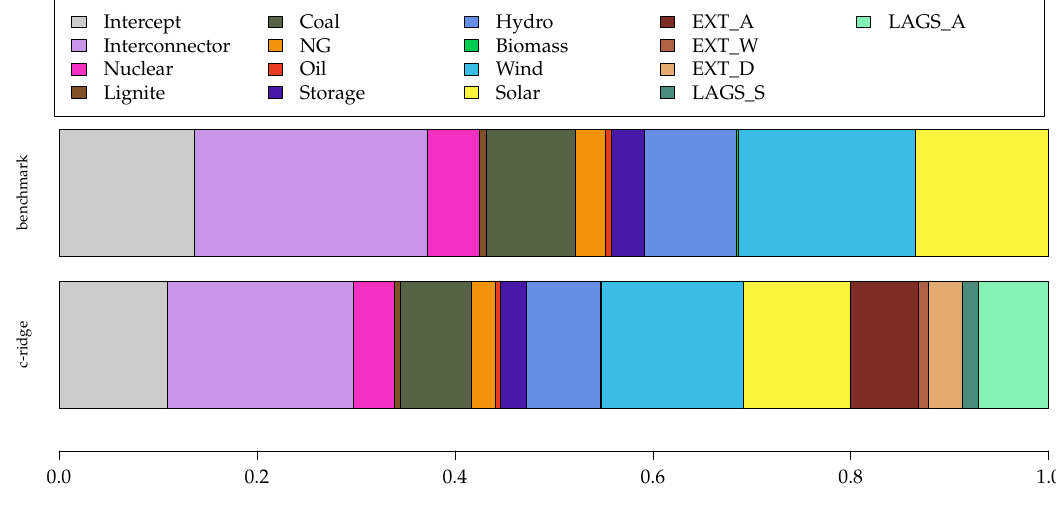
Figure 6. Bar chart of the absolute impact 1month grouped by parameter